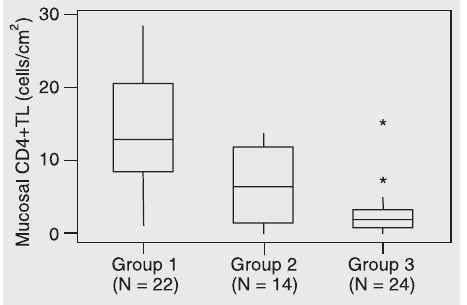
Table 3. Histopathological characteristics of the duodenal mucosa. Variable